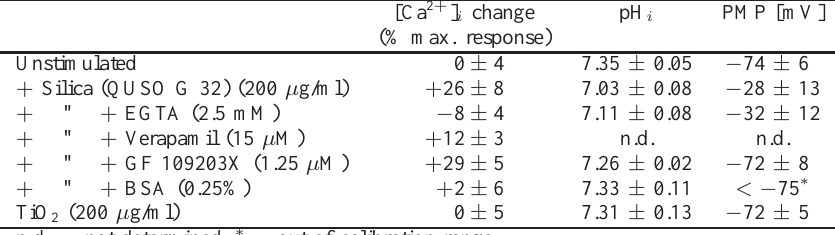
Table 1 Summary of the maximum effects of silica powder QUSO G 32 or titanium dioxide dust on [Ca 2 + ] i , pH i , and PMP. Incubation procedures are described in Fig. 1. Data are mean